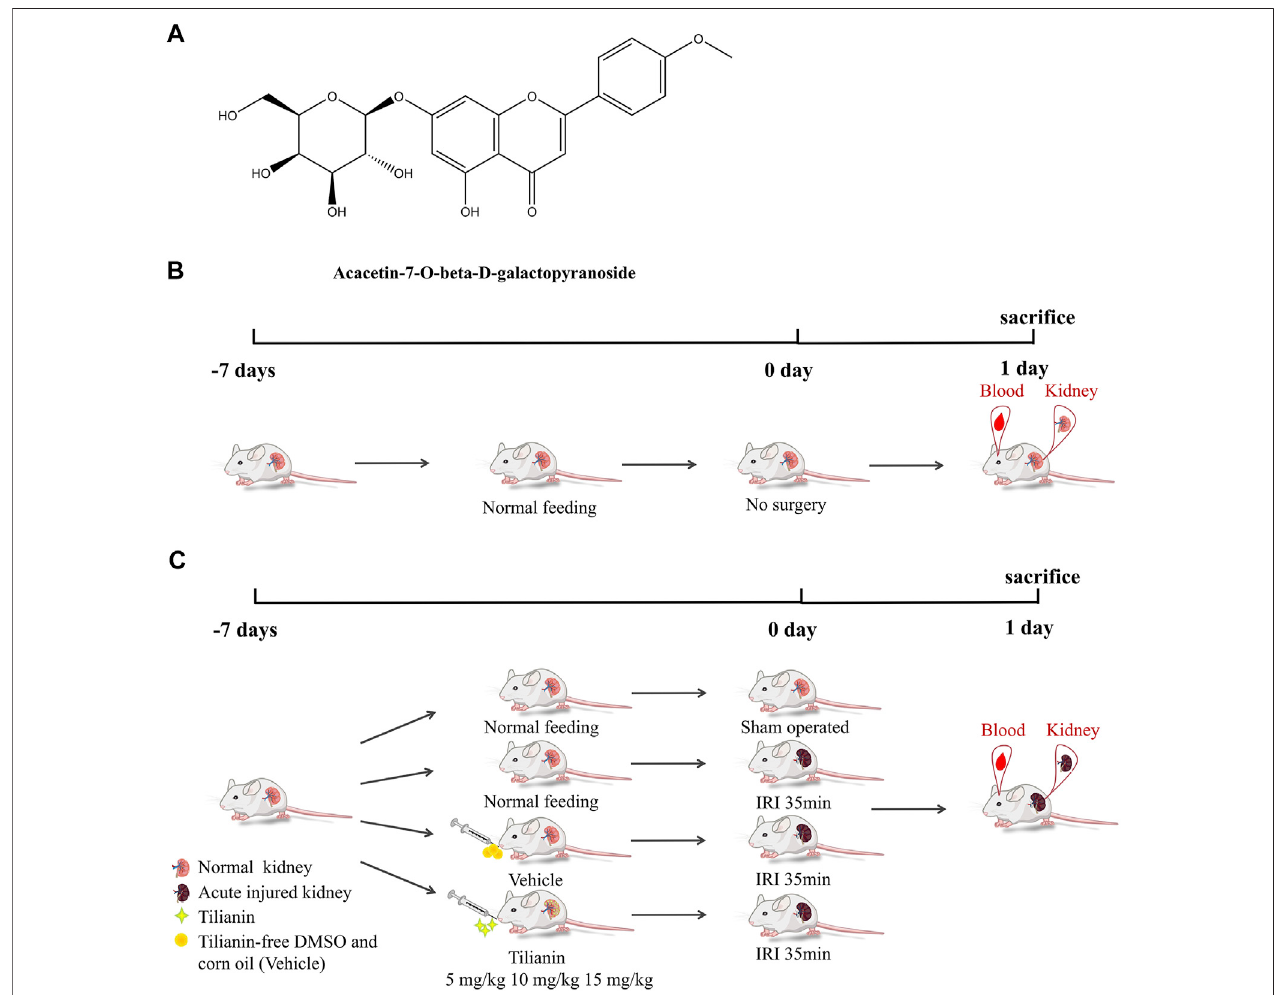
FIGURE 1 | Tilianin and schematic diagram of I/R-induced AKI model establishment, treatment processes, and therapy assessments. (A) Chemical structure of acacetin-7-O-beta- D -galactopyranoside(tilianin). (B) Miceinthecontrolgroupwerefednormallyandexperiencednorenalvascularpedicles. (C) Miceintheshamgroup were subjected to laparotomy and did not suffer from AKI. Groups of I/R-induced AKI mice were fed normally or tilianin (i.g., 5 mg/kg, 10 mg/kg, and 15 mg/kg, once a day, the total for 7 days) or vehicle (i.g., 10 ml/kg, once a day, the total for 7 days).